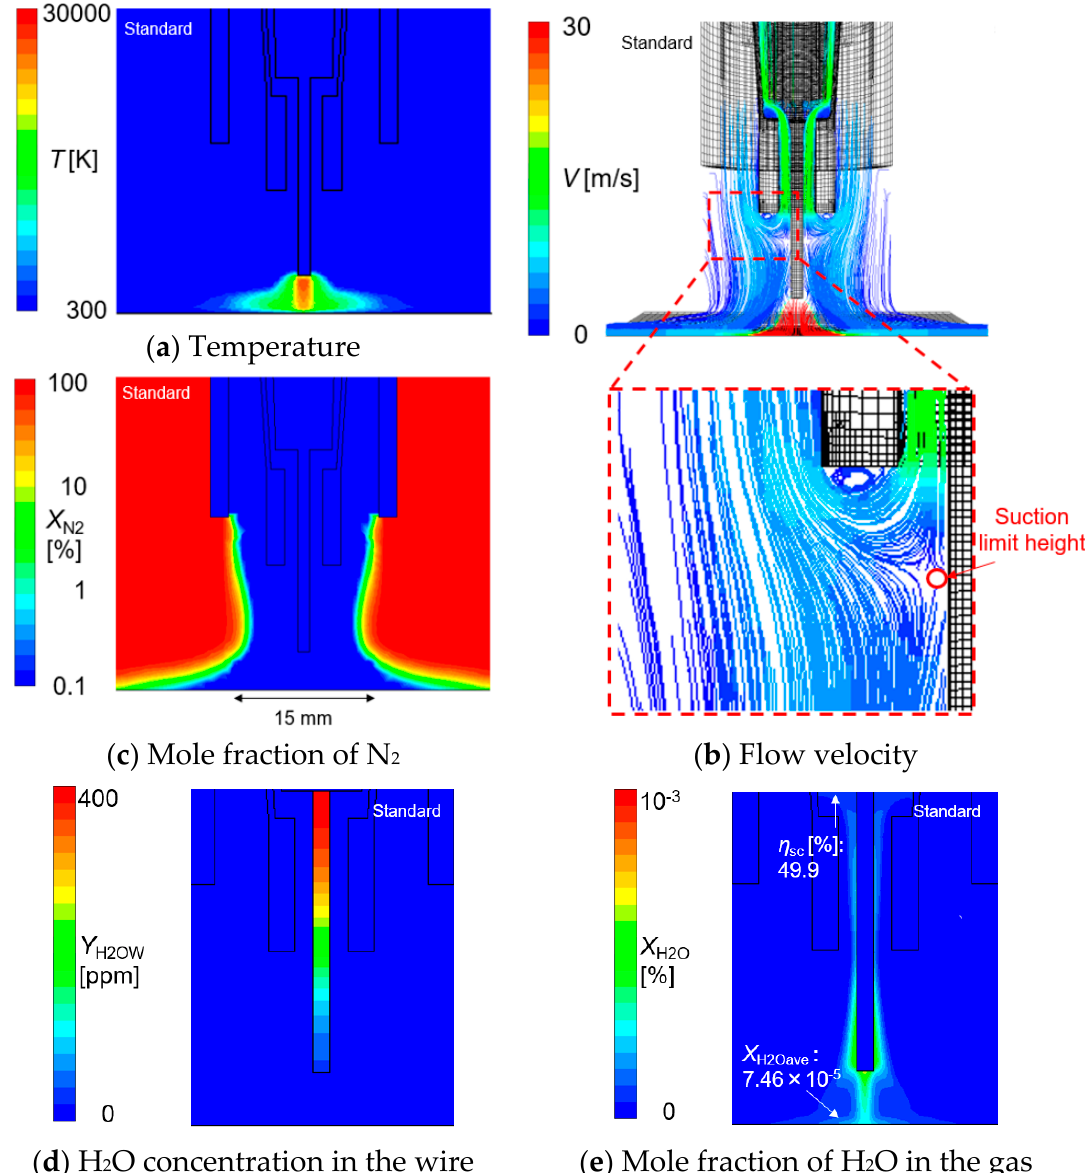
Figure 5. An example of the results in the standard condition: ( a ) temperature, ( b ) flow velocity and ( c ) mole fraction of N 2 , ( d ) H 2 O concentration in the wire and ( e ) mole fraction of H 2 O in the gas.